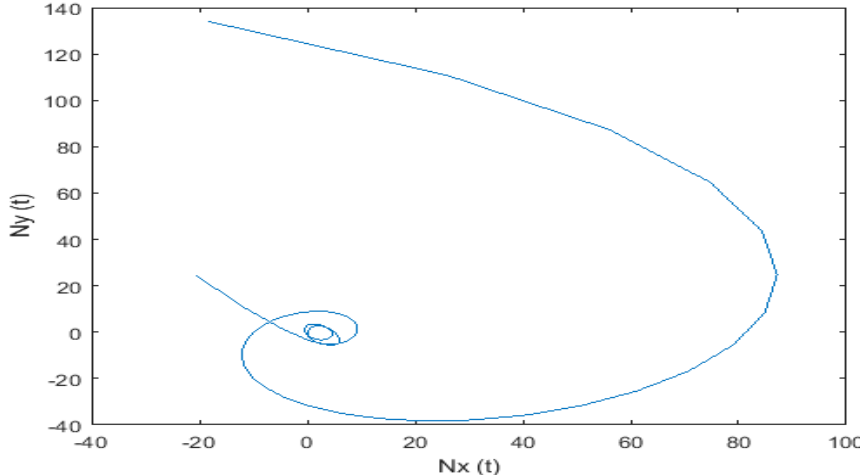
(cid:16) (cid:17) N x vs. N y with parameters: